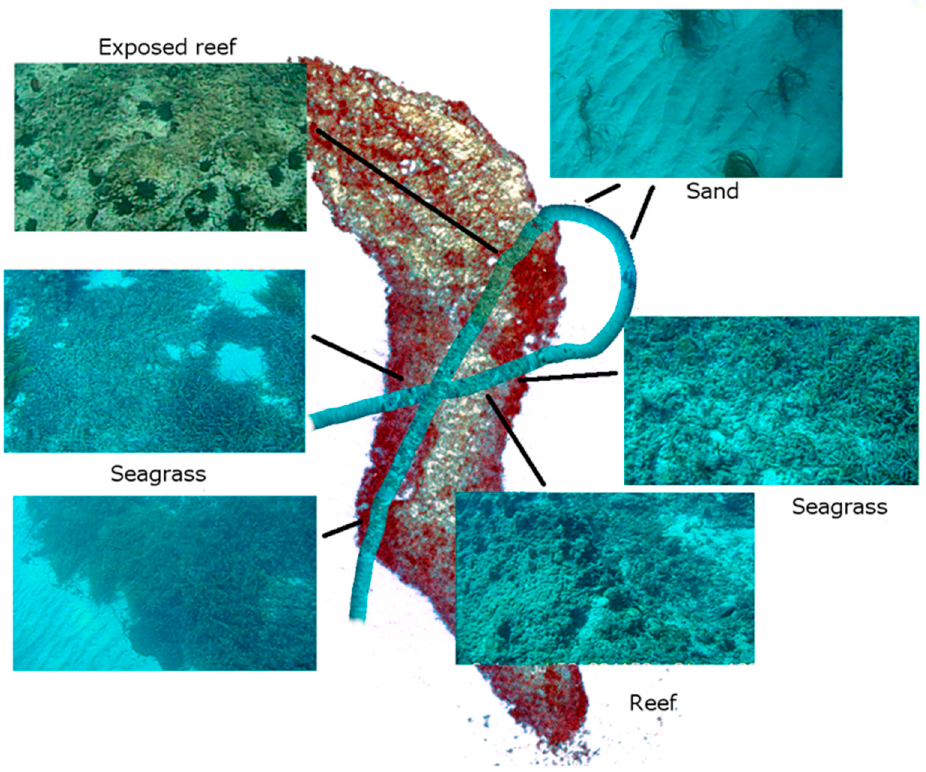
Figure 3. Showing the principal habitats identified in the survey region.